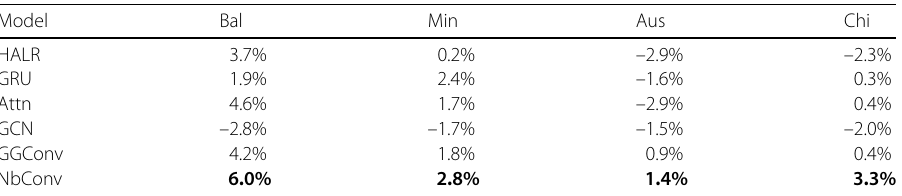
Table 9 Average relative change in F1 score using M for property crimes over all test months (Aug-Dec) in each city